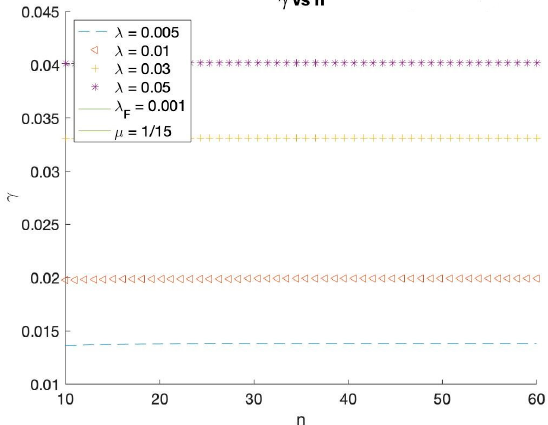
Figure 9. Throughput per block ( (cid:2011) ) vs number of slots ( (cid:1866) ).